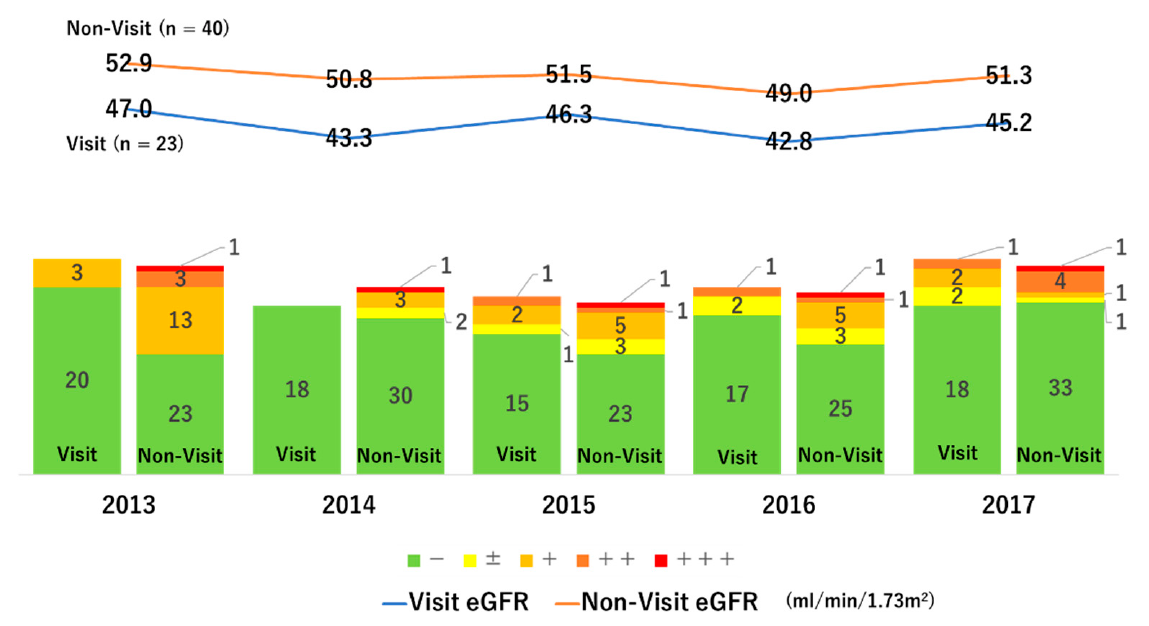
Figure 5. Differences in renal function and urinary protein depending on the presence or absence of medical institution visit. Table 3. Multivariate linear regression for factors influencing ∆ eGFR. Variables